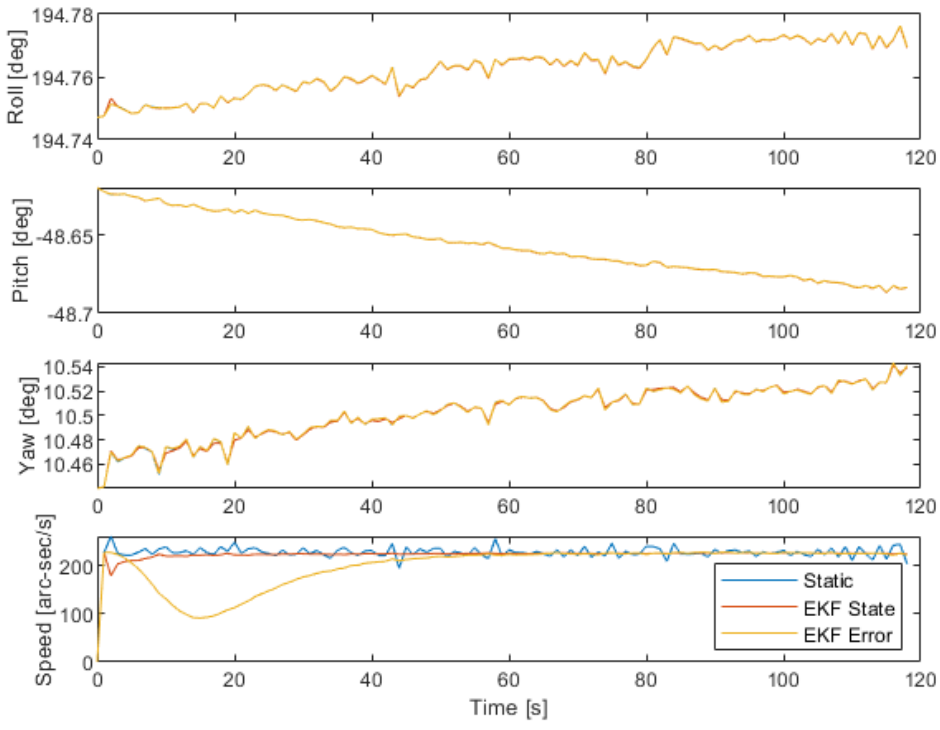
Figure 4. Attitude measurement performance for the standard time step of 1 s, considering each